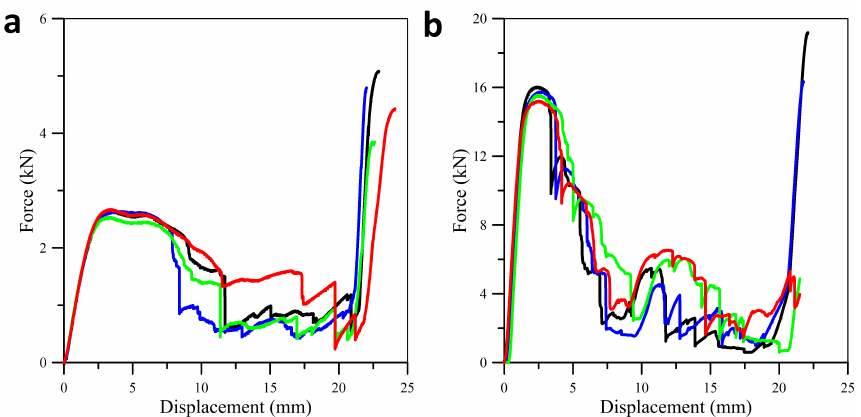
Figure 12. Compressive load and deflection graphs of chiral units with a ligament thickness of ( a ) 0.8 mm, ( b ) 1.6